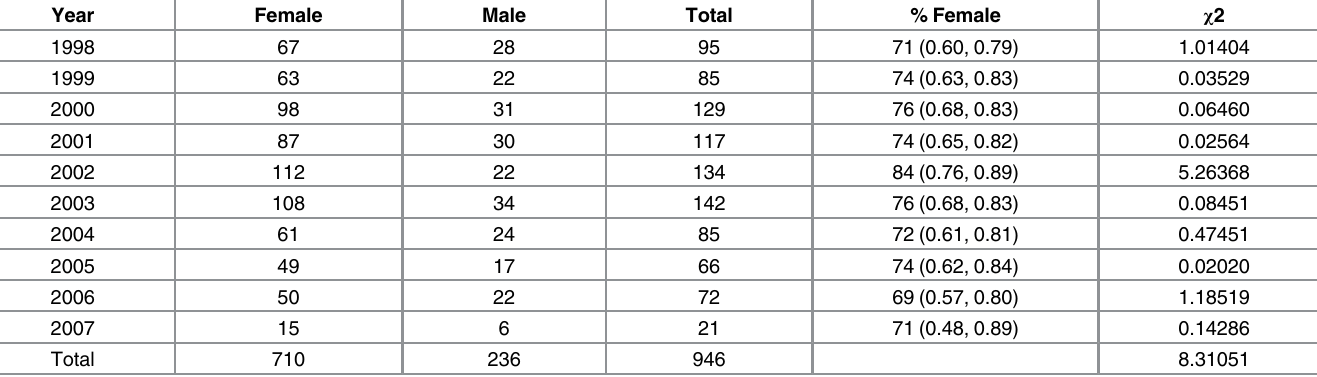
Table 1. Number of females, males, percentage females (95% confidence intervals) and χ 2 values for juvenile loggerhead ( Caretta caretta ) sea turtles.